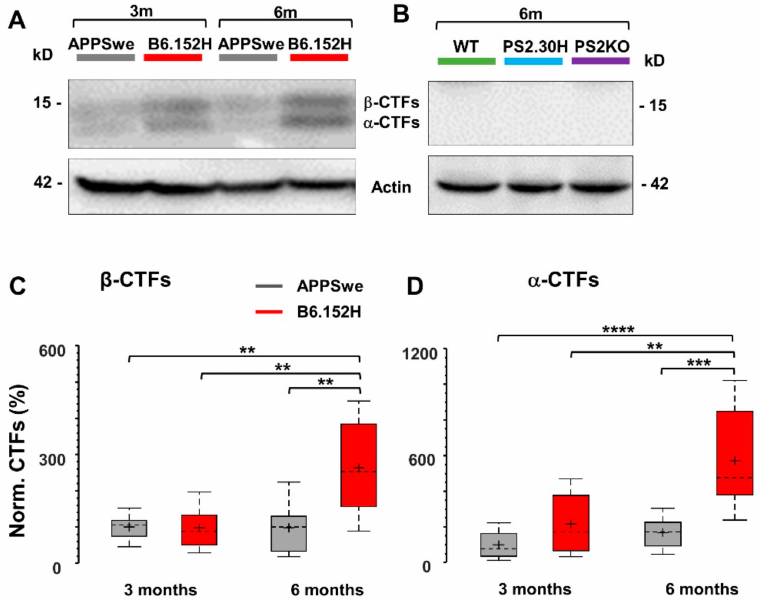
Figure 8. Expression levels of APP-CTFs. Right cortices obtained from three- and six-month-old WT and tg mice were assayed with SDS-PAGE and WB, as described in Supplementary Materials. Representative WB of APP-CTFs, assayed with an anti-APP-CTF (CT695), from APPSwe and B6.152H ( A ) and WT, PS2.30H and PS2KO ( B ) mice. In panel B, even at higher exposure, the CTFs were below threshold. Boxplots of α -( C ) and β -( D ) CTFs ( n = 15 samples from six mice per age and genotype); note the di ff erent scales in panels C and D. Values were normalized to actin and expressed as the percentage of the average value measured in three-month-old APPSwe mice (non-parametric Kruskal-Wallis test with the Dunn-Sydak correction for multiple comparisons, **** p < 0.0001, *** p < 0.001, ** p <